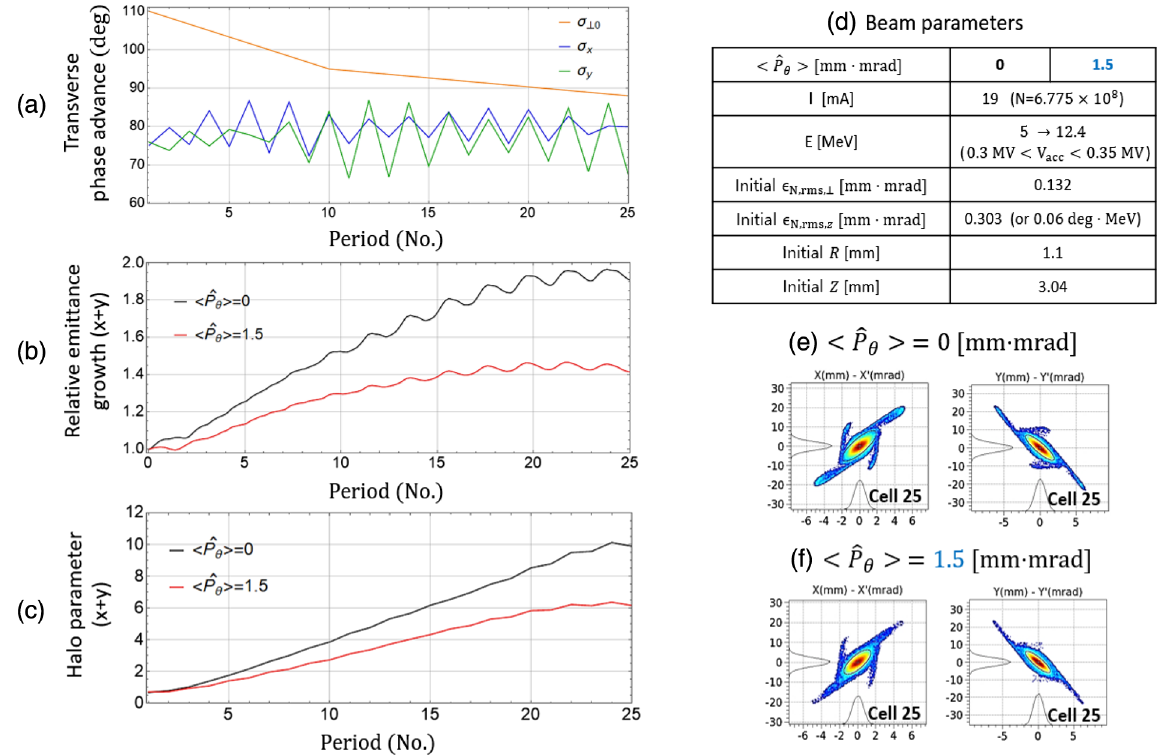
FIG. 8. (a) Transverse phase advances, (b) relative emittance growth, and (c) halo parameter of the nonspinning and spinning beams under the quadrupole focusing lattice. Here, σ ⊥ 0 decreases from 110° to 88° (yellow line) as the beams are accelerated from 5 to 12.4 MeV over 25 periods. The depressed phase advance remains constant around σ ⊥ ∼ 76 ° along the linac (blue and green lines), which is within the fourth-order resonance stop band. (d) The initial beam parameters for nonspinning and spinning beams are the ˆ P 0 and (f) h ˆ P 1 . 5 mm mrad beams. For the spinning beam, the population of same. Phase-space plots are shown for the (e) h θ i ¼ θ i ¼ particles in the four resonance islands is reduced, and the associated emittance growth and halo parameter evidently decrease (red lines). The initial longitudinal phase advance is σ z 0 ¼ 30 °, whereby there is no emittance exchange between the transverse and longitudinal